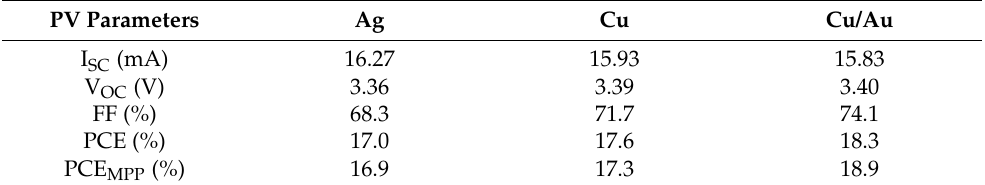
Table 1. Summarized photovoltaic (PV) parameters of perovskite solar mini-modules with different metal top electrodes such as Ag, Cu and Cu/Au, while measured under simulated 1-sun illumination. PV Parameters Ag Cu Cu/Au I SC (mA) 16.27 15.93 15.83 V OC (V) 3.36 FF (%) PCE